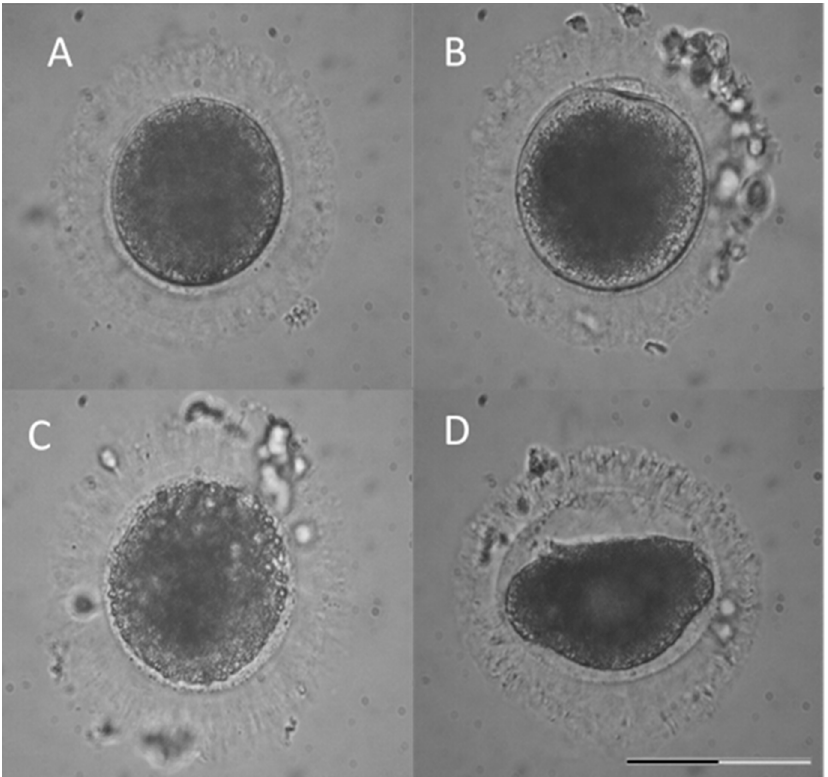
Figure 1. Morphological appearance of the oocytes after warming and IVM. Classified as: ( A ) Normal oocyte, ( B ) normal and mature oocyte, ( C ) oocyte with damaged membrane, and ( D ) shrunken oocyte. Scale bar = 100 µm.